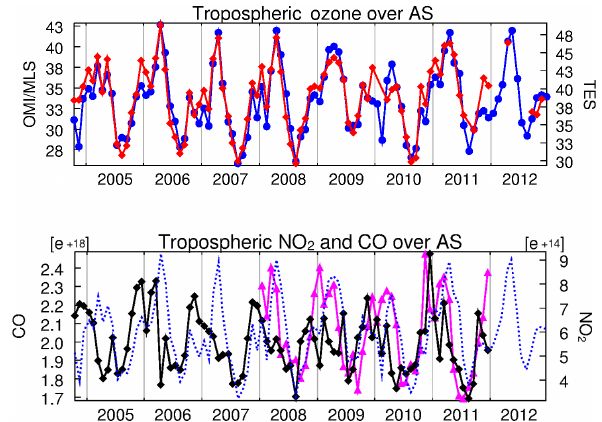
Figure 3. Trace gas time series over AS (10–20 ◦ N, 60–70 ◦ E) from 2004 to 2012. The blue (solid and dotted) curves represent OMI/MLS ozone, red is TES ozone, magenta is IASI CO and black stands for SCIAMACHY NO 2 . The vertical columns are given in DU for ozone and moleccm − 2 for NO 2 and CO. The region used for this time series calculation is marked with a red rectan- gle in Fig. 2. The time series of TOC from SCIAMACHY, MACC, OMI.MLS and TES in the year 2008 is presented in Appendix Fig. A3.